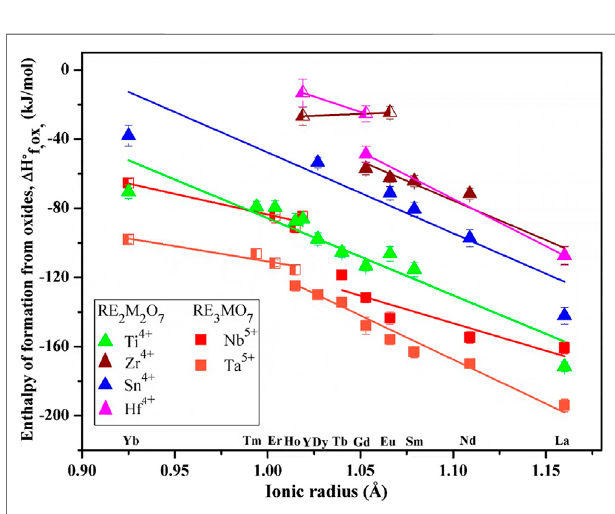
FIGURE3| Enthalpiesofformation vs. ionicradiusofrareearthions.The fi lled squares show compounds with weberite structure. The fi lled triangles represent compounds with ordered pyrochlore structure. The half- fi lled squares and triangles indicate compounds with disordered defect fl uorite structure. The data for RE 2 Ti 2 O 7 and RE 2 Sn 2 O 7 are from Helean et al. (2004) and Lian et al. (2006). The data for RE 2 Zr 2 O 7 are from Navrotsky and Ushakov (2005), Radha et al. (2009), and Saradhi et al. (2012). The data for